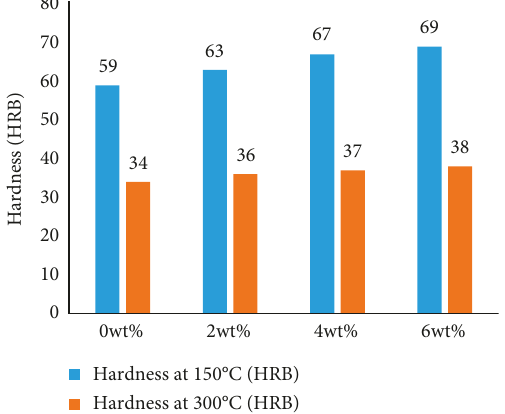
Figure 6: Effect of reinforcing particles on tensile strength of AA7050/Al 2 O 3 composites.